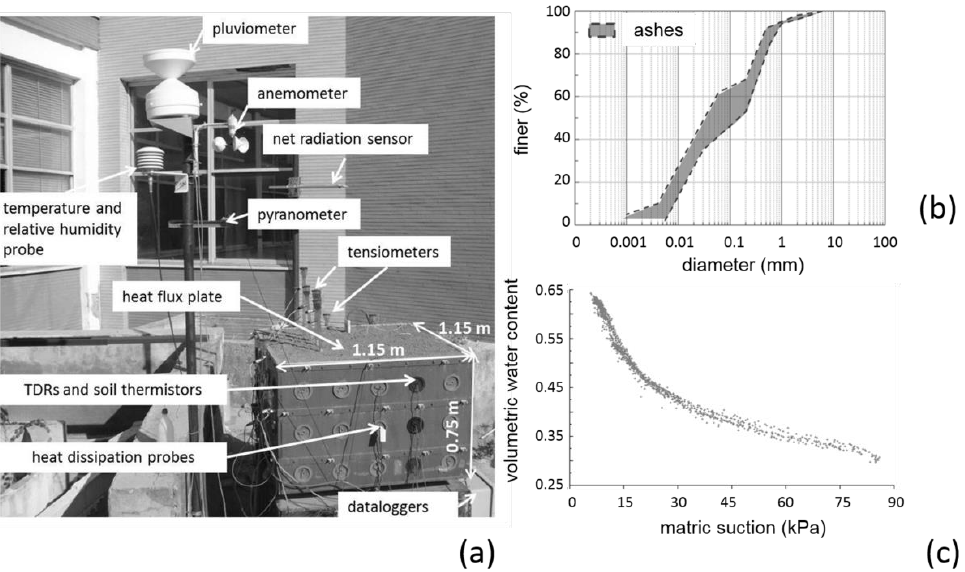
Figure 2. ( a ) View of the physical prototype and the sensors utilized; ( b ) grain size distribution of the soils investigated; ( c ) Soil-Water Characteristic Curve retrieved by coupling the water content and pore pressure readings at a depth of 15 cm.